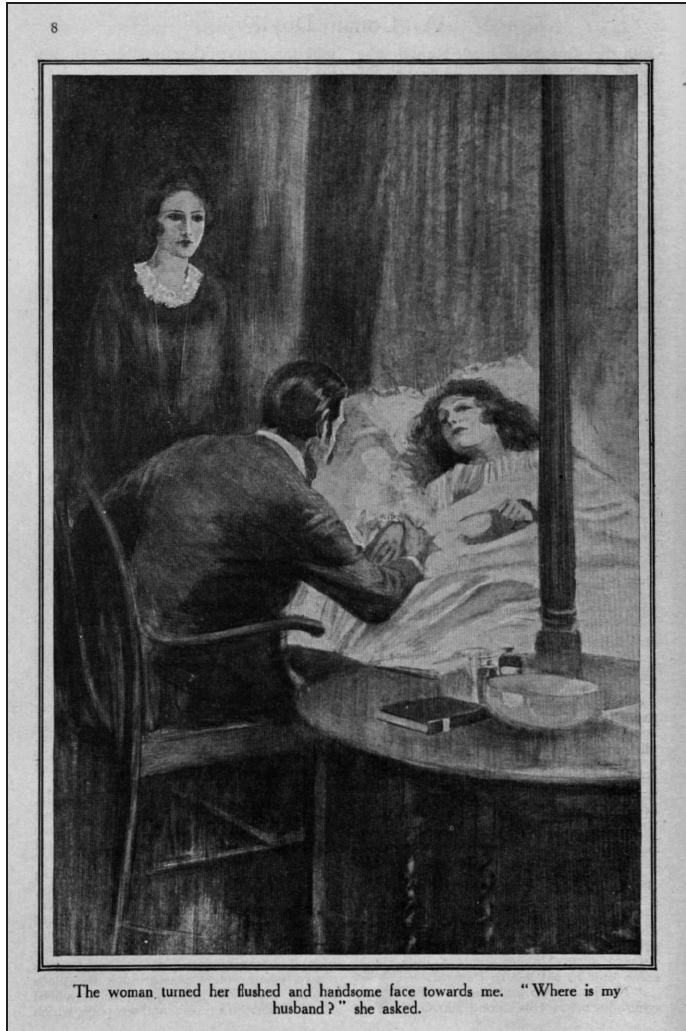
Figure 1: Howard K. Elcock evokes Dracula in his depiction of Mrs